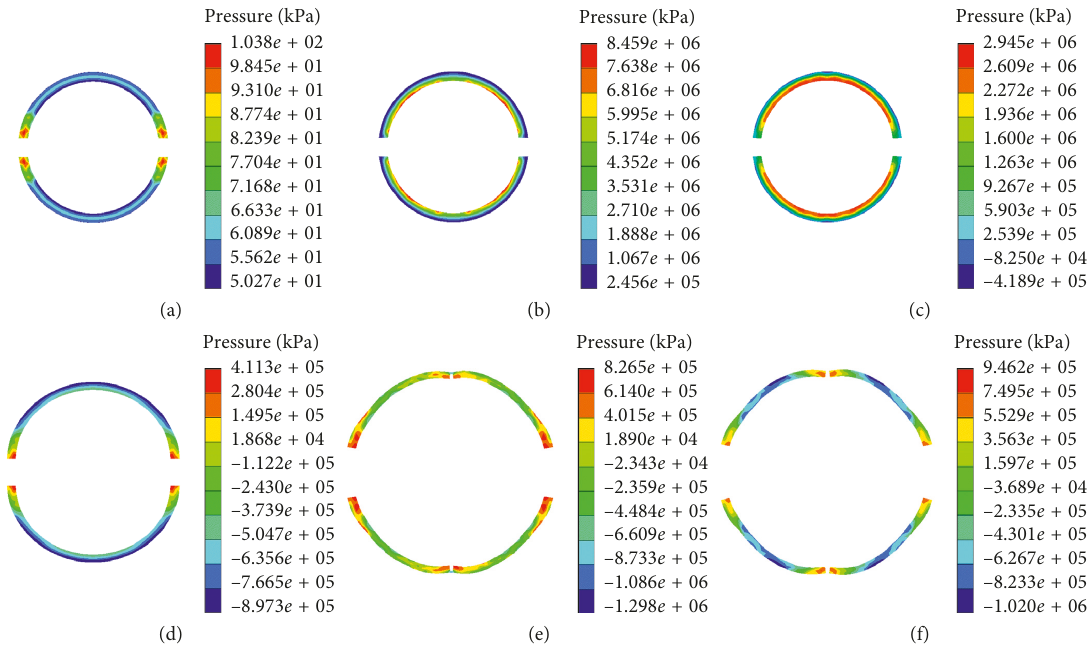
Figure 14: Dynamic pressure of split-tube